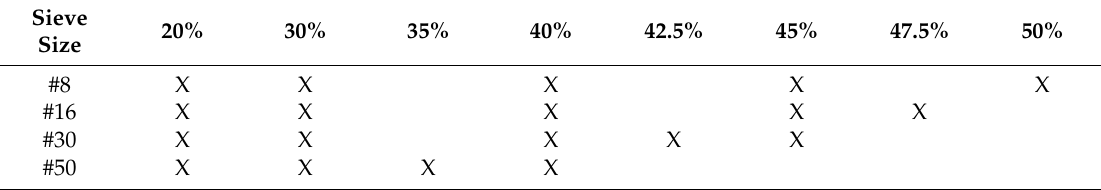
Table 5. Evaluated volume fractions for each sand portion with listed maximum aggregate size.